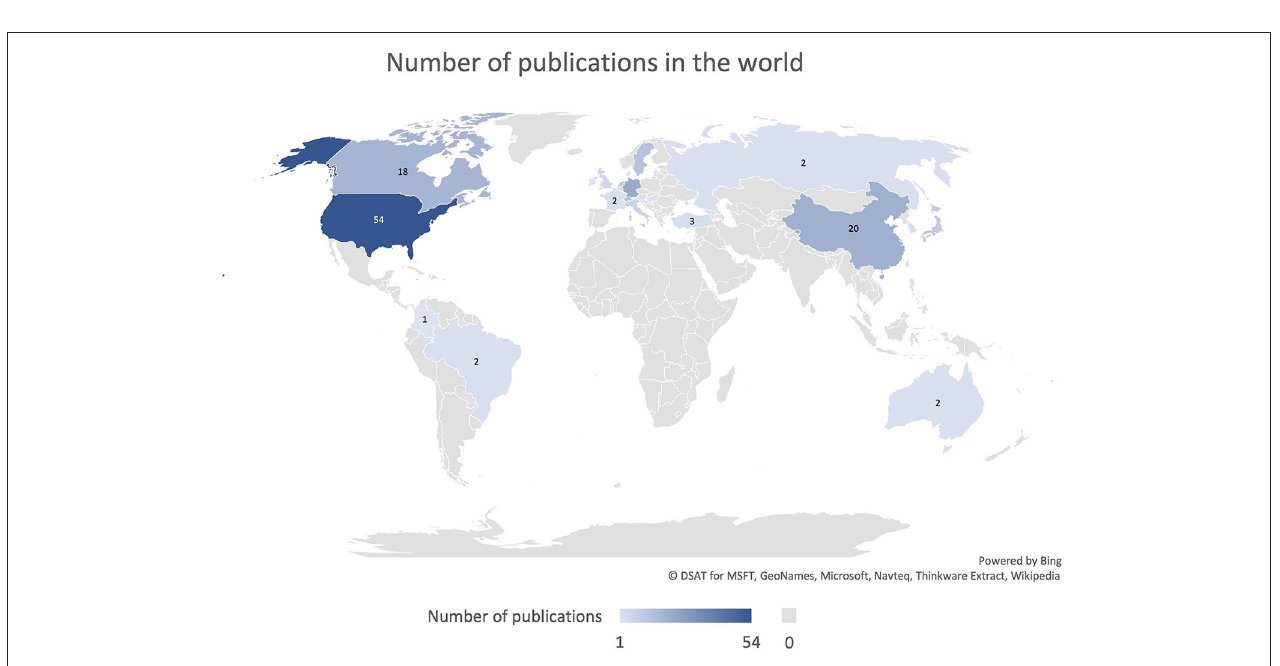
FIGURE 2 | Diagram representing the number of publications per